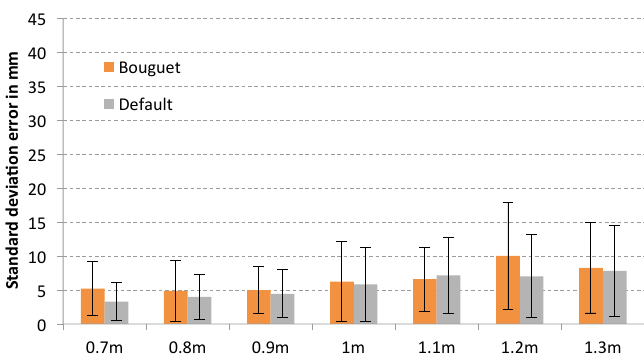
Figure 13. Plane fitting test error of each calibration method for Microsoft Kinect V2.